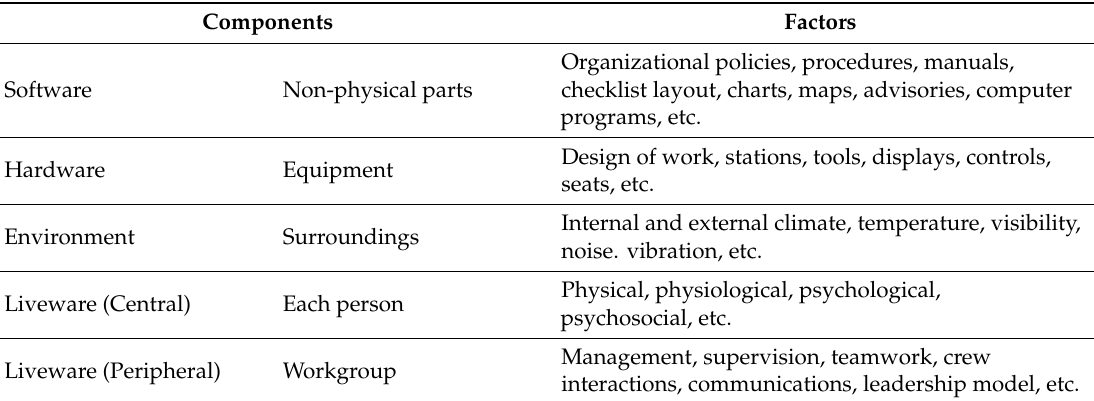
Table 2. Elements of the SHEL